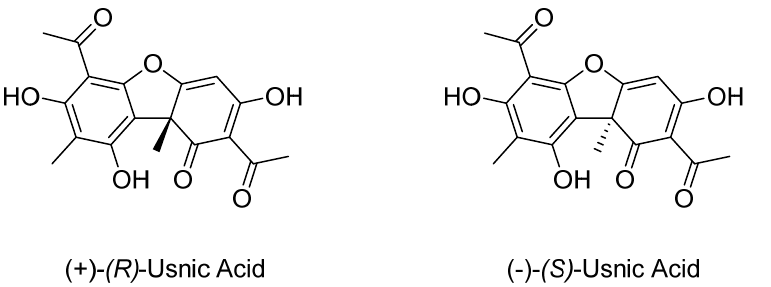
Figure 1. Chemical structure of usnic acid (UA) enantiomers.